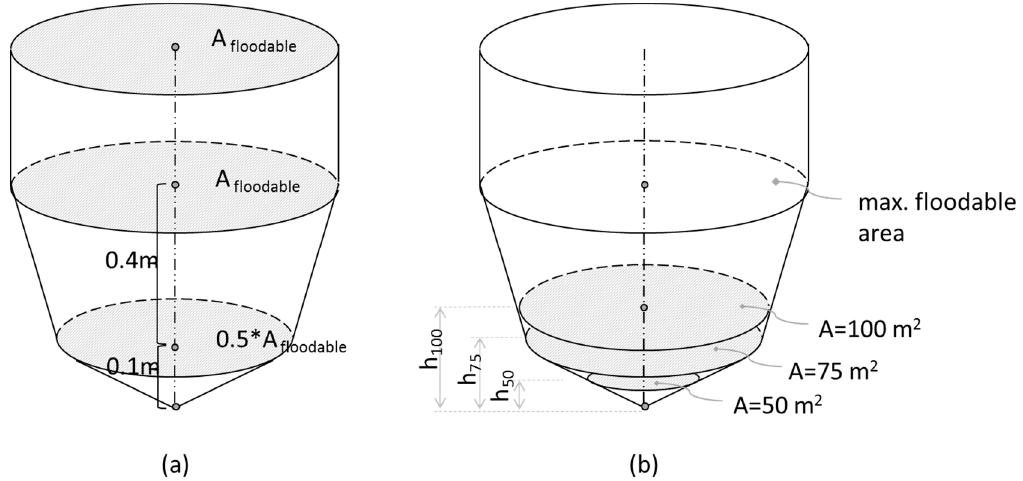
Figure 6. Flood cone on top of a manhole in the hydrodynamic model storing water above street level. ( a ) The relationship between flood volume and water level above the street; ( b ) Three threshold areas 50, 75, and 100 m 2 , including the corresponding threshold water levels h 50 , h 75 , and h 100 for assessing the sensitivity of the results.